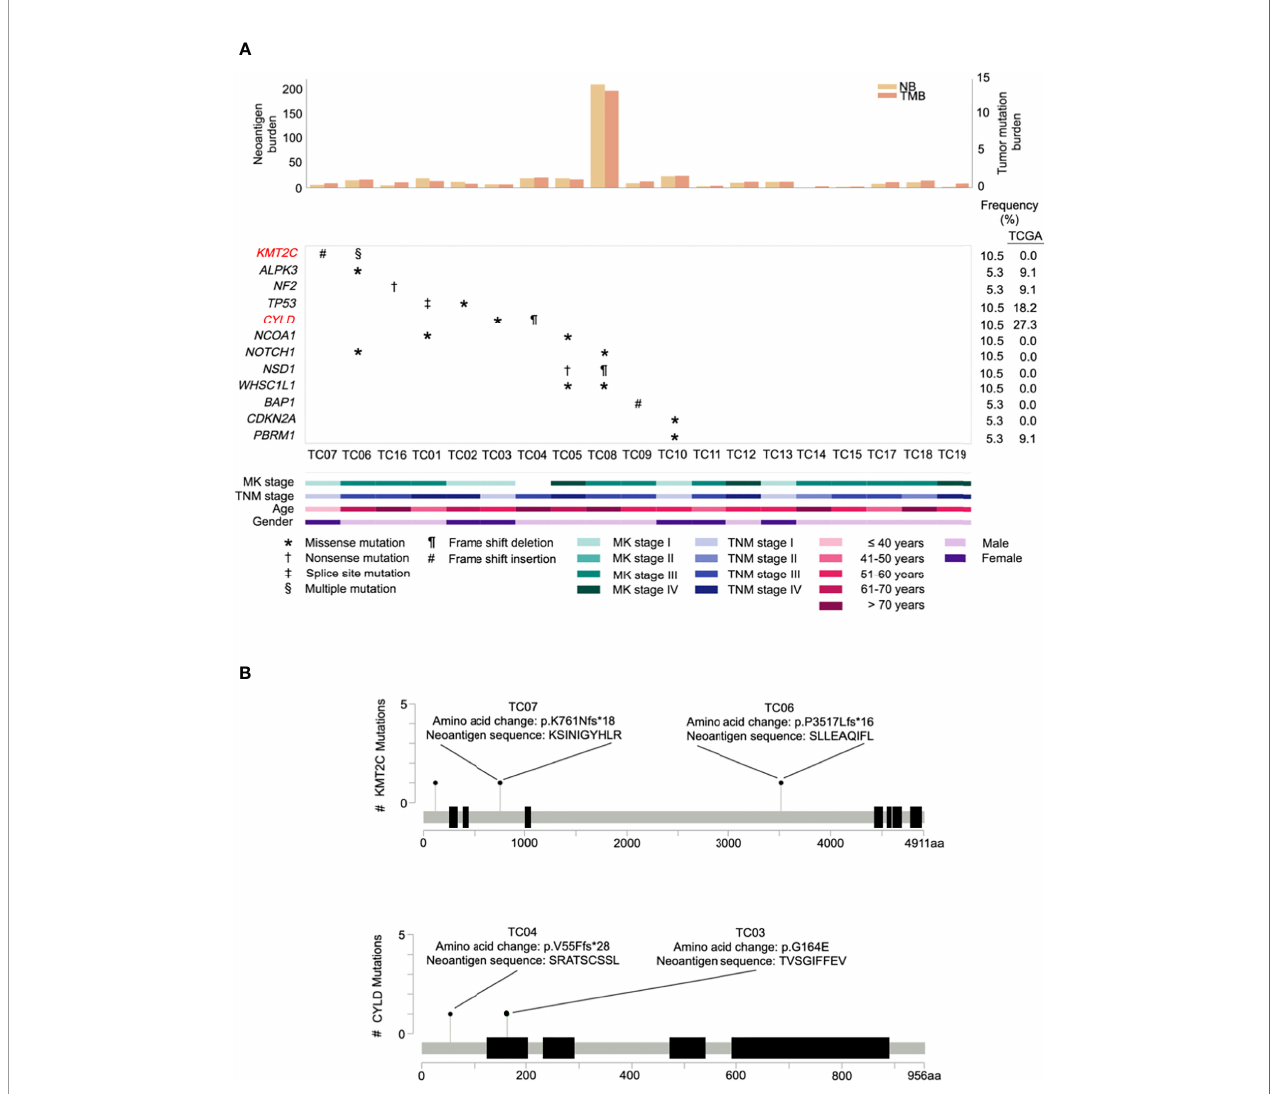
FIGURE 2 | Repertoire of oncogenic alterations with neoantigens in thymic carcinoma patients (n = 19). (A) CoMut plot for each patient (column). Top: left y-axis for neoantigen burden, total number of predicted neoantigens; right y-axis for tumor mutational burden, i.e., mutations/covered bases. Middle: Row represents signi fi cantly mutated genes, curated driver genes of thymic carcinoma, and frequency of occurrence in our cohort and The Cancer Genome Atlas (TCGA) cohort. Signi fi cantly mutated genes are those exhibiting a signi fi cantly higher mutation rate than expected of the background mutation rate in the cancer cohort (30). Symbols indicate the type of somatic mutation. Bottom: Clinical characteristics of thymic carcinoma patients. MK stage, Masaoka Koga stage. (B) Lollipop plots of mutations for genes KMT2C and CYLD with predicted neoantigens. The heights indicate the number of mutations in patients. The amino acid change and its neoantigen sequence are annotated above the